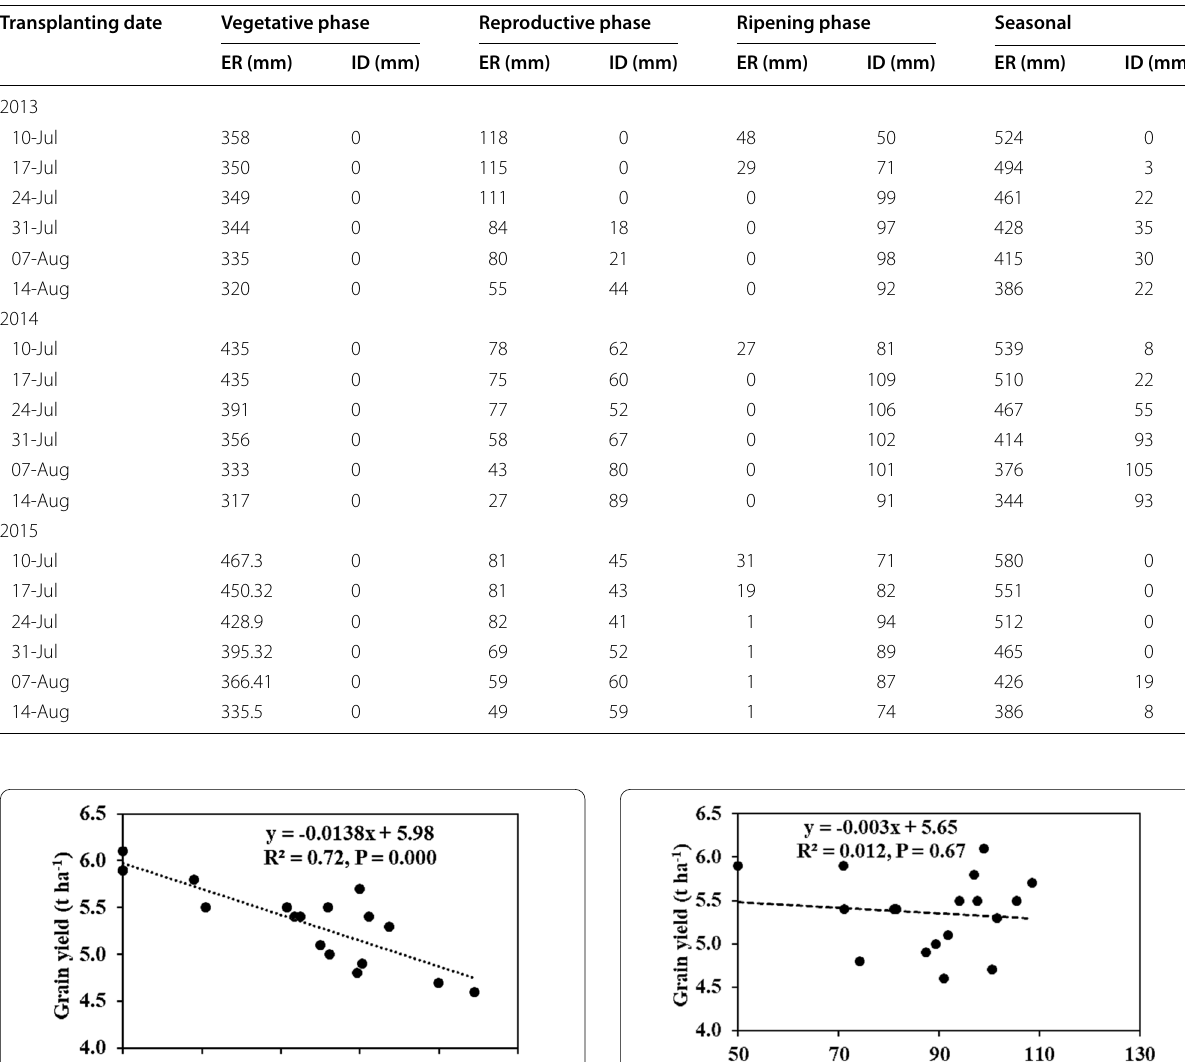
Table 2 Effective rainfall (ER) and irrigation demand (ID) amount at different growth stages under varying transplanting dates during T. Aman 2013–2015 in Kushtia